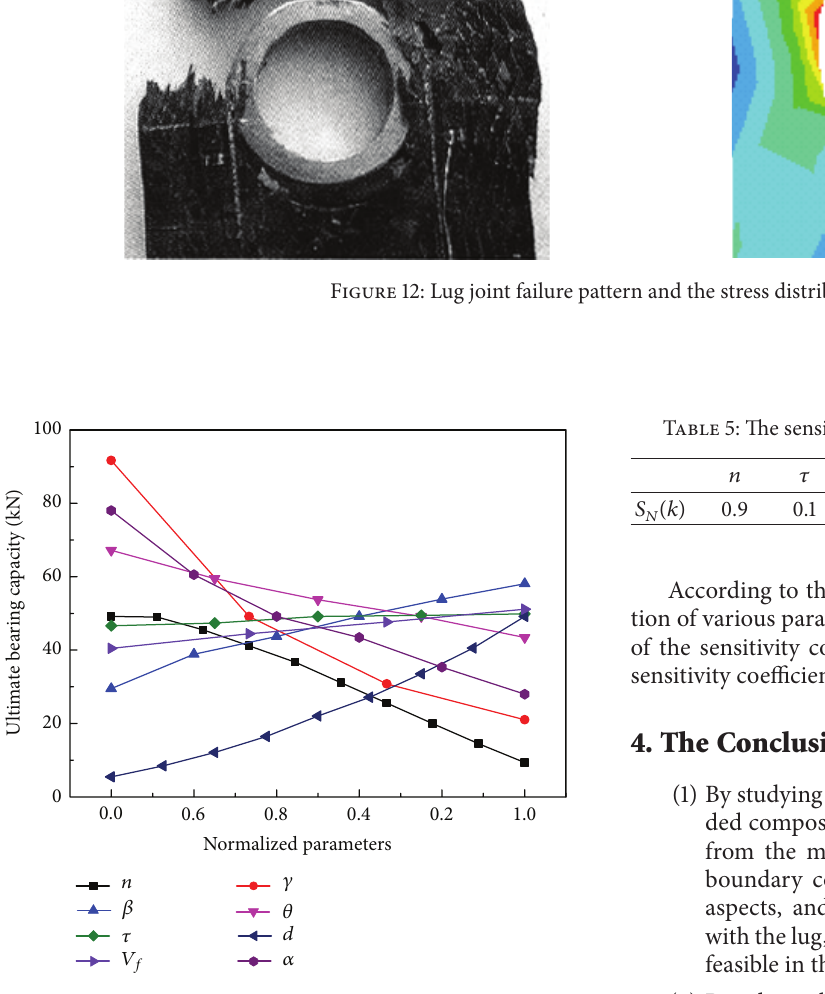
Figure 13: Relationship between ultimate bearing capacity and the normalized parameters.